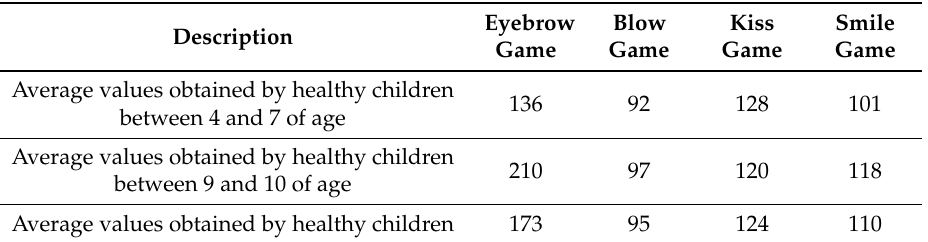
Table 2. Average values obtained for each game in tests with healthy children.